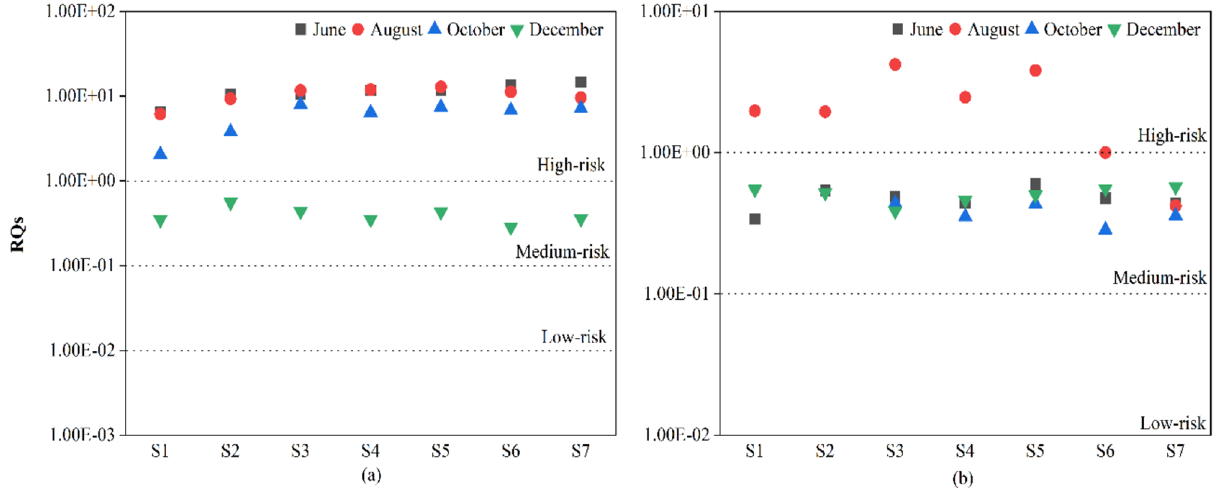
Figure 5. Ecological risks of NOR and OFL in Yitong River, Changchun. ( a , b ) represent the ecological risks of antibiotic NOR and OFL, respectively. Low risk RQ < 0.1, Medium risk (0.1 < RQ < 1), High risk (RQ >